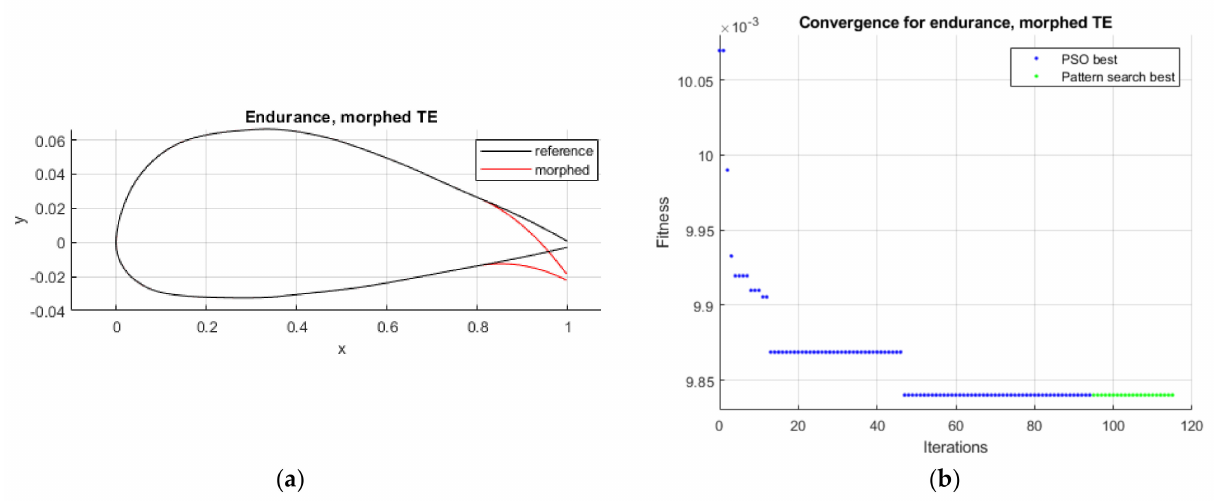
Figure 23. Optimized airfoil and convergence history for endurance maximization function. ( a ) the initial (reference) versus the final (optimized or morphed) airfoil shape; ( b ) the convergence graph of the aerodynamic endurance